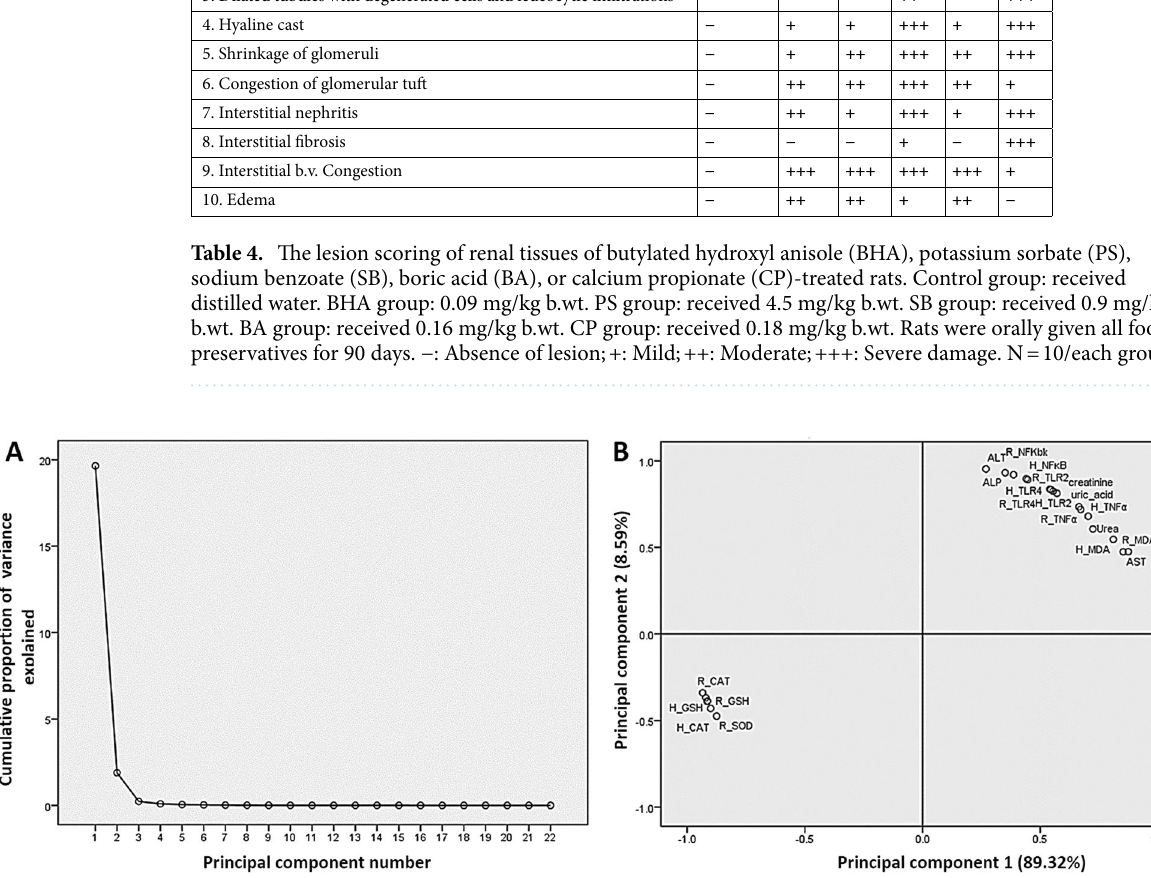
Figure 5. The principal component analysis plot shows the estimated variables’ relationships. ( A ) Cumulative proportion of variance as a function of the number of principal components (PC). ( B ) All biochemical and gene expressions indicators are plotted as a function of PC1 and PC2, which account for 89.32% and 8.59% of the variance, respectively. H_ hepatic, R_ renal, AST aspartate transaminase, ALT alanine